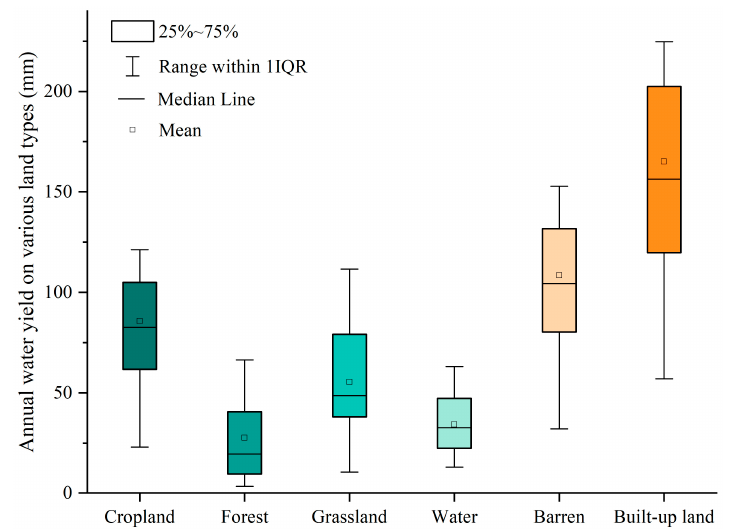
Figure 8. Water yield of different land use types in the HBOY Region.